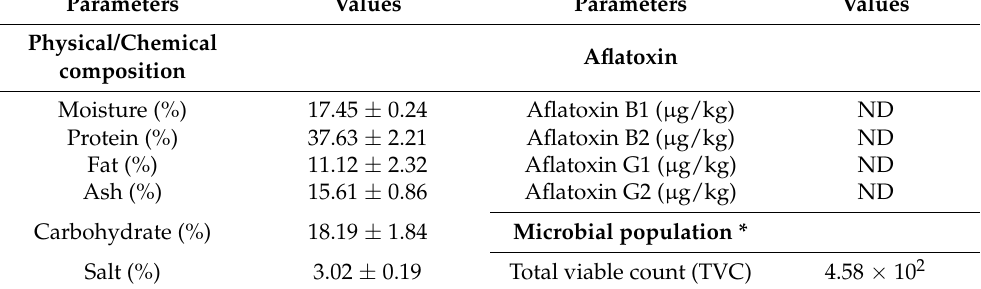
Table 1. Chemical composition, physical properties, microbial population, and sensory evaluation of dried chili fish paste. Parameters Values Parameters Values